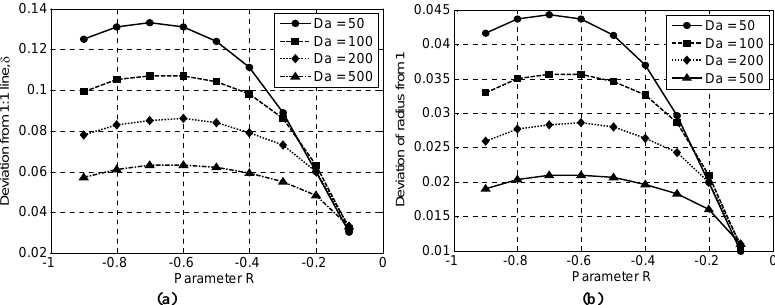
Figure 17. (a) Dependencies of the r.m.s. distance of the e N − e q relationship curve from straight line 1:1 suggested by classical concept of extremely inhomogeneous mixing. The dependencies are plotted for different values of Da and R . (b) The same as to the left panel but for r.m.s. deviations of the mean volume radius curve from that initial constant value assumed in the classical